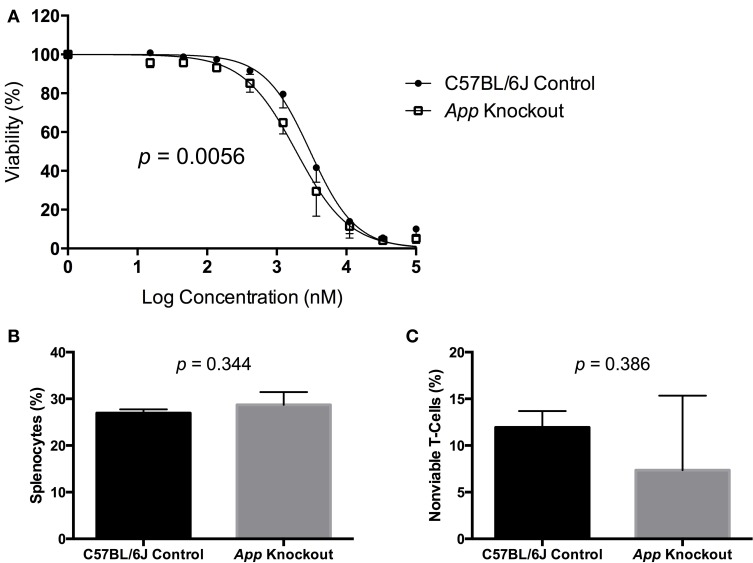
In vitro validation of App in T-cell toxicity following idarubicin exposure. Dose-response curves (A) and baseline splenic T-cell composition (B) and non-viable T-cells (C) are shown. Dose-response curves were generated following exposure of splenic T-cells from C57BL/6J control mice (N = 3) and App knockout mice (N = 3) to idarubicin. A significant shift to the left was observed in App knockout cells as calculated using a partial F-test (p = 0.0056). At the zero dose, the relative splenic T-cell composition and viability of App knockout vs. control mice were not statistically different using a t-test (p > 0.05, respectively p = 0.344 and p = 0.386).